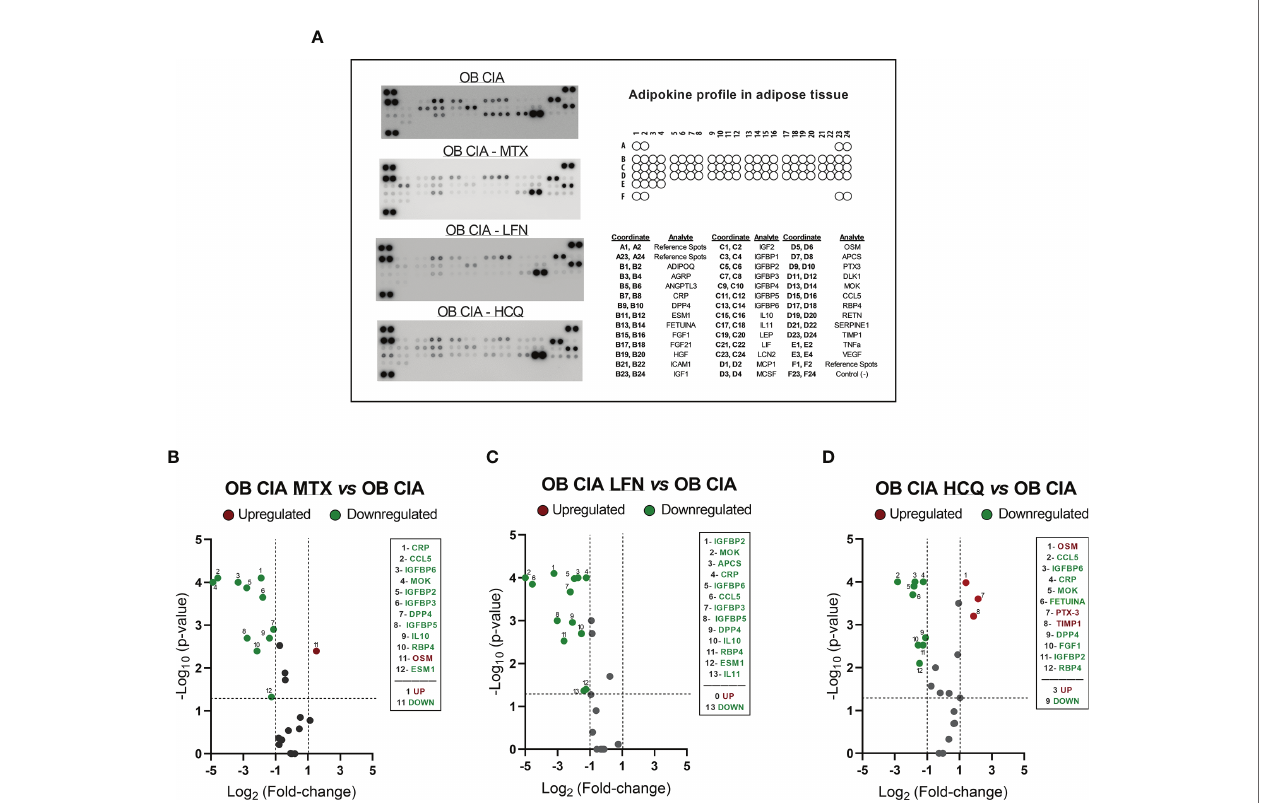
FIGURE 6 | Adipokine pro fi ling in adipose tissue of OB CIA mice treated with conventional DMARDs. (A) Representative images of mouse adipokine array and the coordinate reference of proteins; (B) Volcano plot of modi fi ed proteins in OB CIA mice treated with MTX; (C) Volcano plot of modi fi ed proteins in OB CIA mice treated with LFN; (D) Volcano plot of modi fi ed proteins in OB CIA mice treated with HCQ. Volcano plots compare the fold change and p-value of the expression of proteins between groups. Vertical dashes mark the fold change (>1), and horizontal lines mark the p-value cutoff of 0.05. Signi fi cance was determined by Student t-test (unpaired). ADIPOQ, adiponectin; AGRP, agouti-related neuropeptide; ANGPTL3, angiopoietin like 3; CRP, C-reactive protein; DPP4, dipeptidyl peptidase 4; ESM1, endothelial cell speci fi c molecule 1; FGF, fi broblast growth factor; HGF, hepatocyte growth factor; ICAM1, intercellular adhesion molecule 1; IGF, insulin like growth factor; IGFBP, insulin-like growth factor binding protein; IL, interleukin; LEP, leptin; LIF, leukemia inhibitory factor; LCN2, lipocalin-2; MCP1, monocyte chemoattractant protein-1; MCSF, macrophage colony stimulating factor-1; OSM, oncostatin M; APCS, amyloid P component serum; PTX3, pentraxin 3; DLK1, delta like non-canonical notch ligand 1; MOK, MAPK overlapping kinase; CCL5, C-C motif chemokine ligand 5; RBP4, retinol binding protein 4; RETN, resistin; SERPINE1, serpin family E receptor member 1; TIMP1, tissue inhibitor of metalloproteinases 1; TNF- a , tumor necrosis factor alpha; VEGF, vascular endothelial growth factor; CIA, collagen-induced arthritis; OB, obese; MTX, methotrexate; LFN, le fl unomide; HCQ,